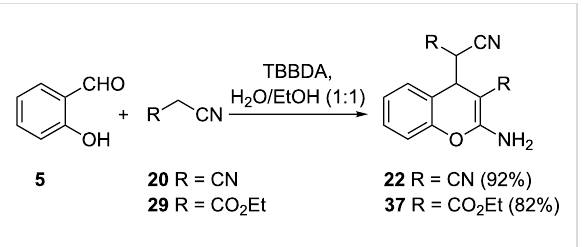
Scheme 15: Synthesis of 2-iminochromene 21 by Heravi and